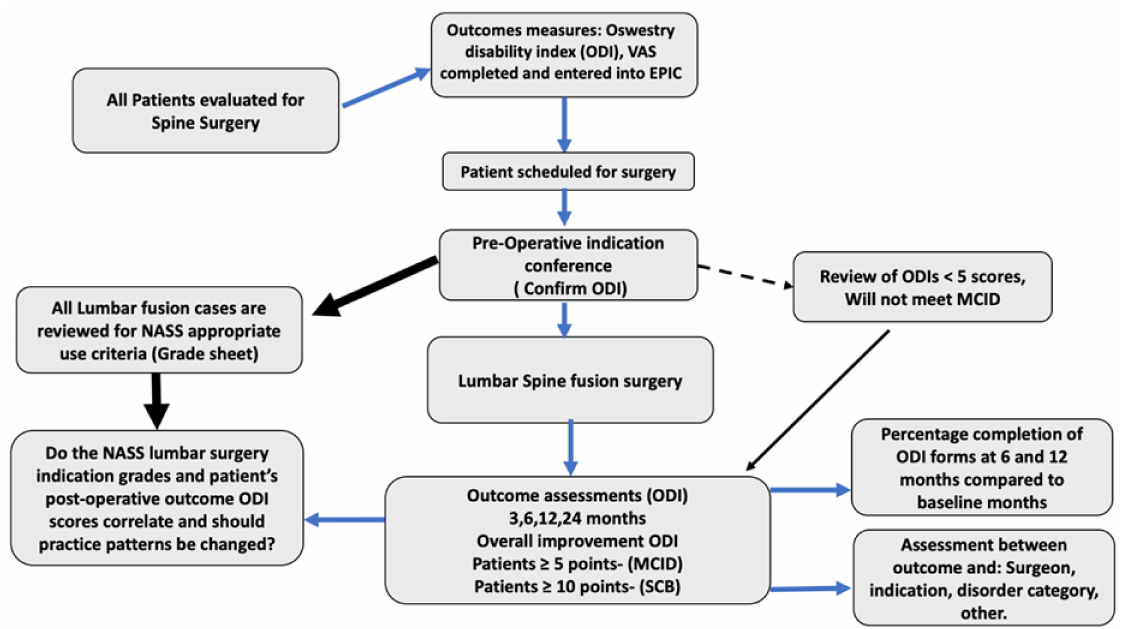
Figure 1. Flowchart describing the patient selection process for